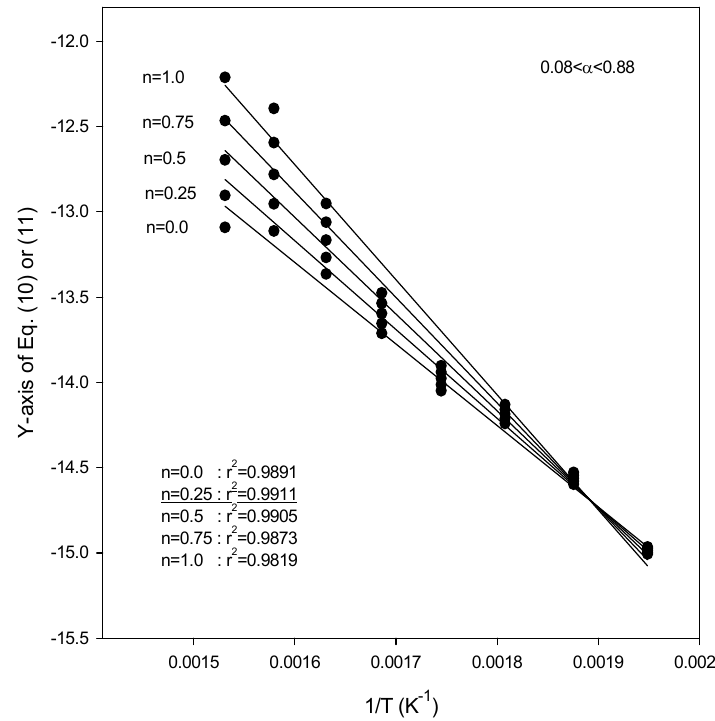
Figure 5. Plots of Equations (10) or (11) for the application of the kinetic analysis method at a heating rate of 9.8 °C/min for